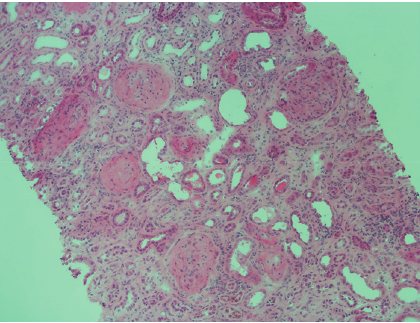
Figure 3: Renal biopsy showing extracapillary crescentic glo- merulonephritis involving almost all glomeruli (HE, 100x).